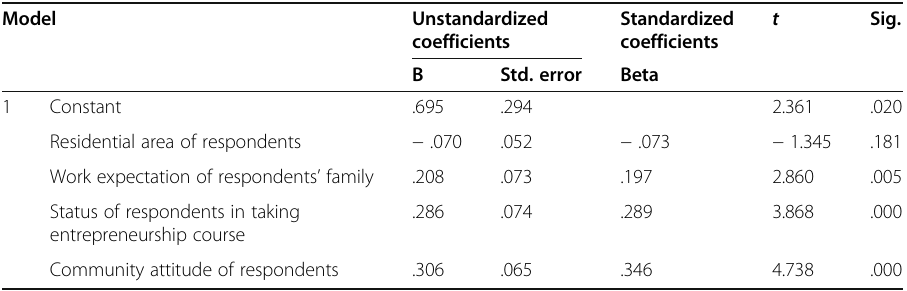
Table 3 Regression coefficients